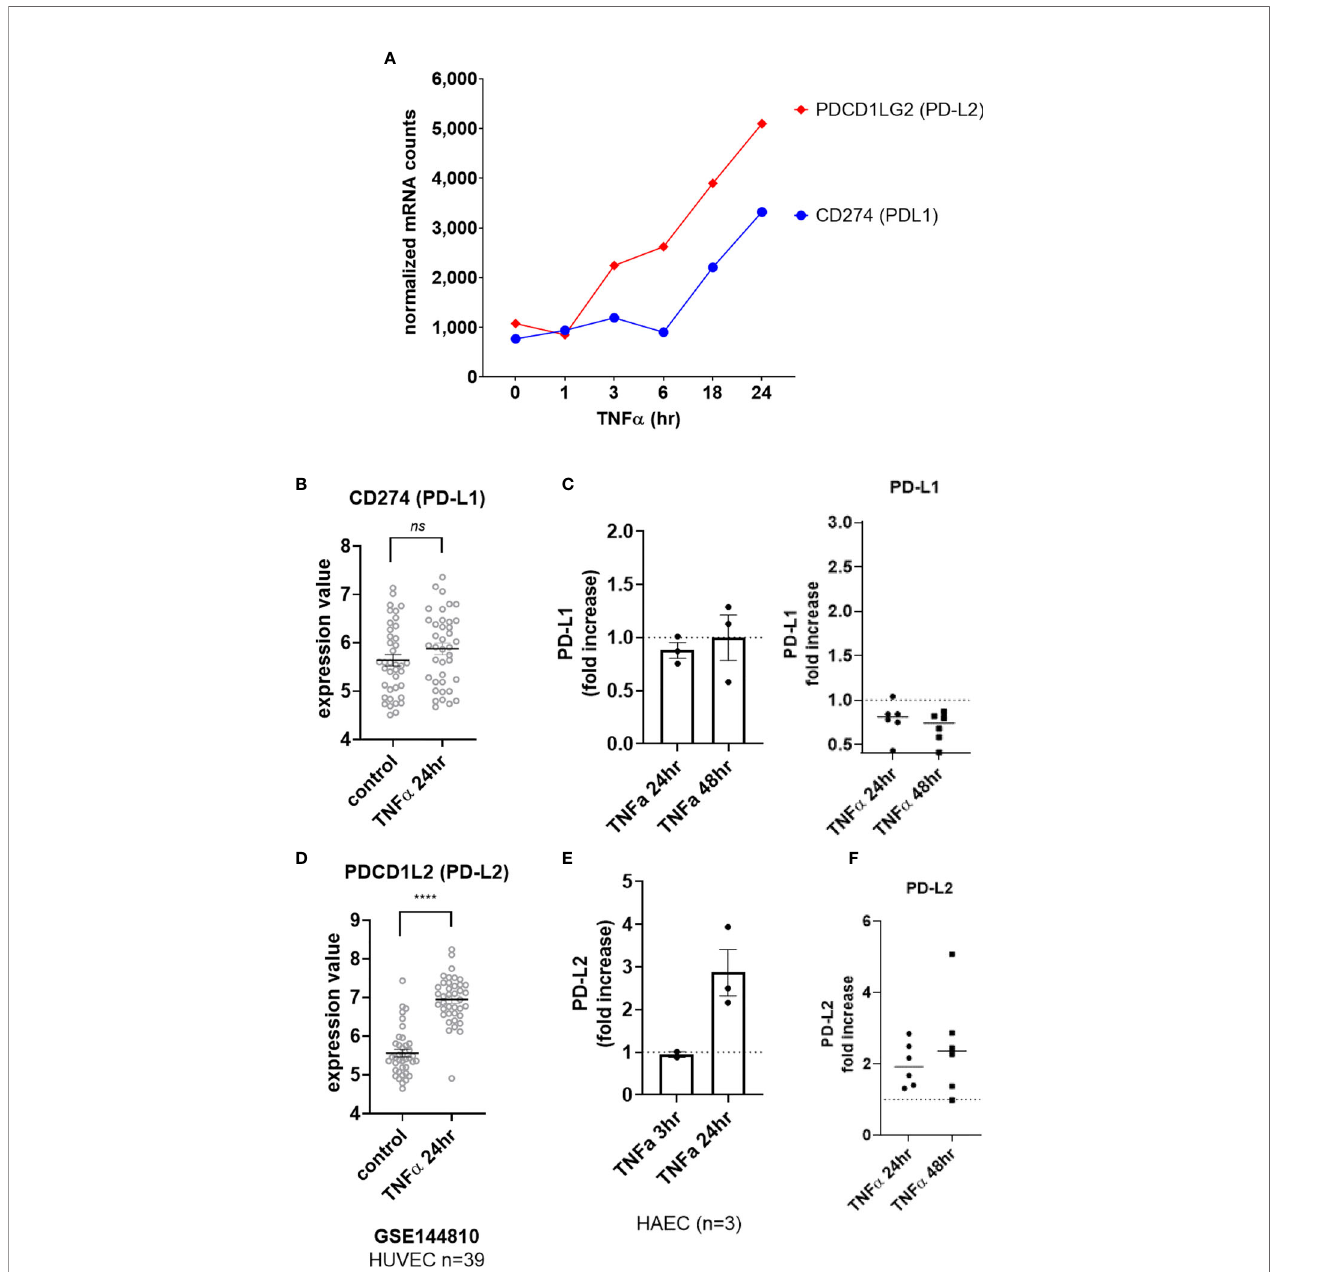
FIGURE 5 | TNF a induced endothelial expression of PD-1 ligands. (A) HMEC-1 endothelial cells were stimulated with TNF a (20ng/mL) for 1hr, 3hr, 6hr, 18hr or 24hr. Time course of TNF a induced costimulatory molecule mRNA for CD274 and PDCD1LG2 in HMEC-1. One representative experiment is shown. Results are presented as absolute number of normalized mRNA counts for each gene, normalized to housekeeping controls. (B) Expression values of CD274 from GSE144810 are plotted, comparing HUVEC (n=39) left untreated or stimulated with TNF a for 24hr. Value distributions were compared by unpaired t test. Results are presented with each measured value, and the line at the median. (C) Primary human endothelial cells (HAEC, HCAEC, HCMVEC, HPAEC, HPMVEC, HLSEC) were stimulated with TNF a for 24hr or 48hr. Cell surface PD-L1 protein was stained and detected by fl ow cytometry. Results are presented as the fold increase in MFI compared with untreated conditions for each EC type. Left panel shows HAEC (n=3); right panel shows fold change in MFI across EC from different vascular beds (n=6). (D) Expression values of PDCD1L2 from GSE144810 are plotted, comparing HUVEC (n=39) left untreated or stimulated with TNF a for 24hr. Value distributions were compared by unpaired t test. Results are presented with each measured value, and the line at the median. ****p < 0.0001 compared to control. (E) Primary human aortic endothelial cells (n=3 donors) were stimulated with TNF a for 3hr or 24hr. Cell surface PD-L1 and PD-L2 were measured by fl ow cytometry. Results are presented as the fold increase in MFI compared with untreated conditions, mean ± SEM. (F) Primary human endothelial cells (HAEC, HCAEC, HCMVEC, HPAEC, HPMVEC, HLSEC) were stimulated with TNF a for 24hr or 48hr. Cell surface PD-L2 protein was stained and detected by fl ow cytometry. Results are presented as the fold increase in MFI compared with untreated conditions. not signi fi cant, ns p >